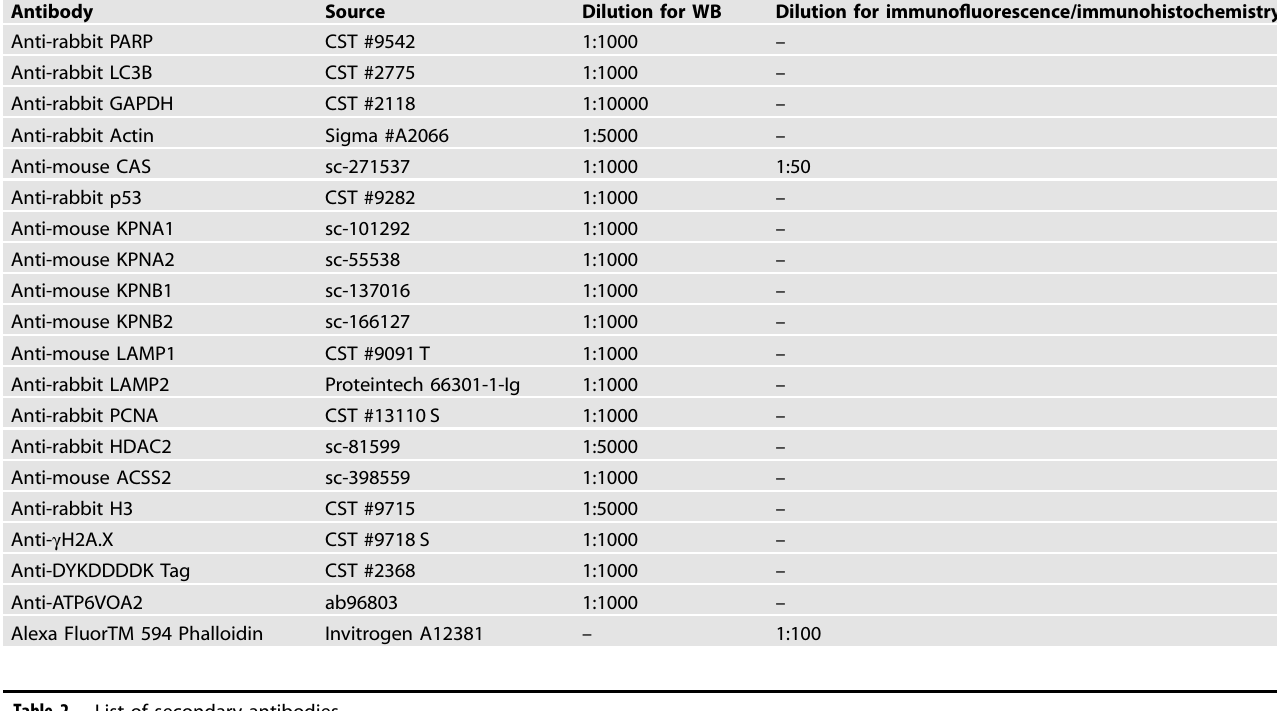
Table 1. List of primary antibodies.